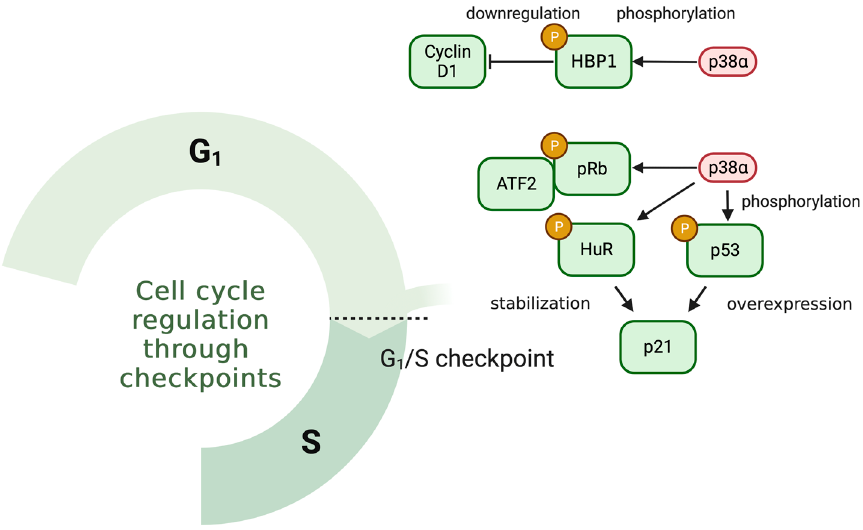
Figure 2. p38 α controls cell cycle arrest in G1 through several mechanisms. Within its family, p38 α is the main regulator of the G1/S checkpoint through different mechanisms, implicating key proteins, such as pRB, p53 and p21/WAF, in this checkpoint.